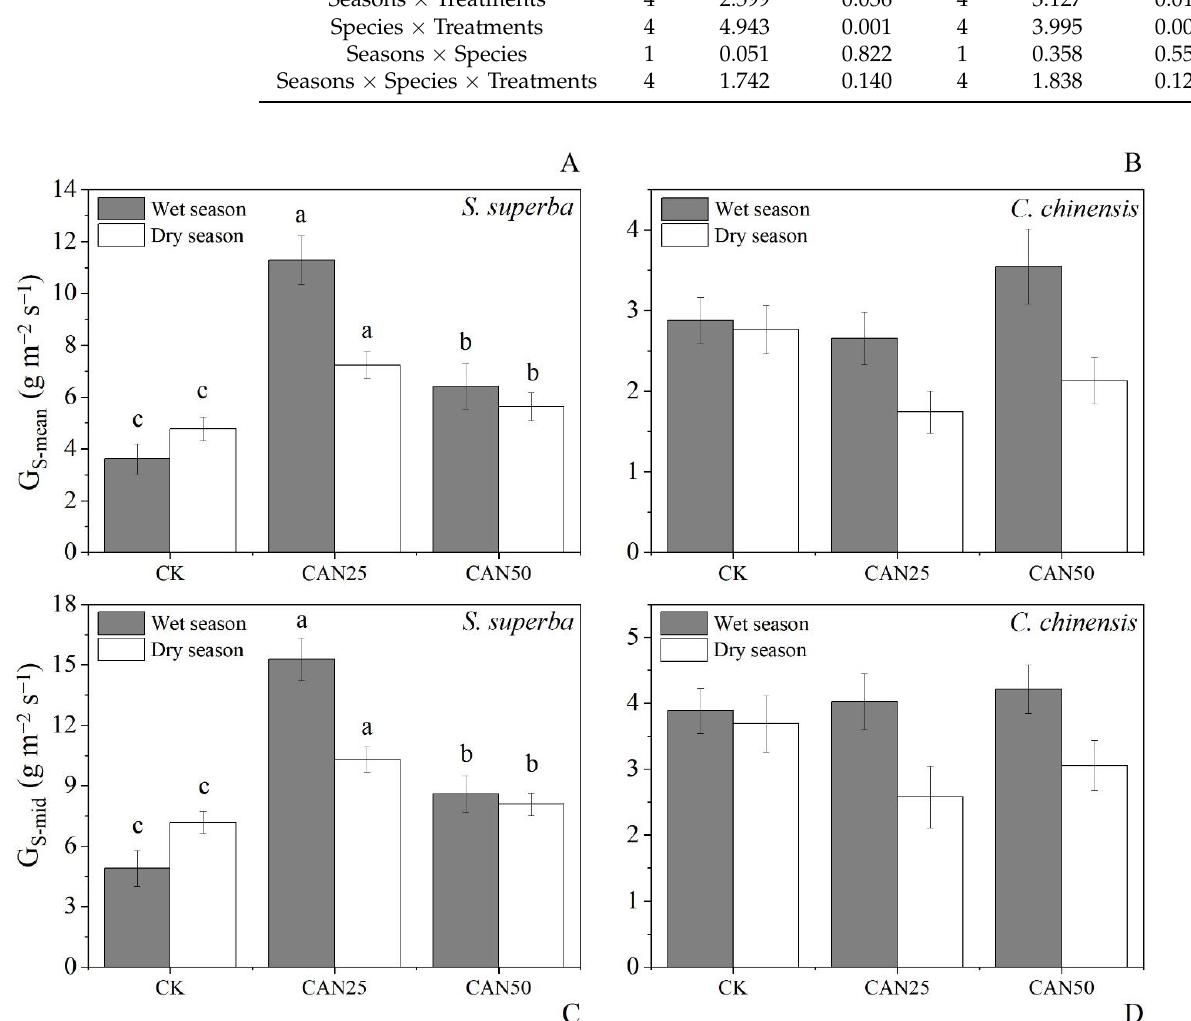
Figure 4. Daily mean stomatal conductance (G S-mean ) and mid-day stomatal conductance (G S-mid ) under different N treatments for S. superba ( A , C ) and C. chinensis ( B , D ), and in the dry and wet seasons, different letters indicate significant differences at p < 0.05. Table 1. ANOVA on the J S-mean and J S-mid .